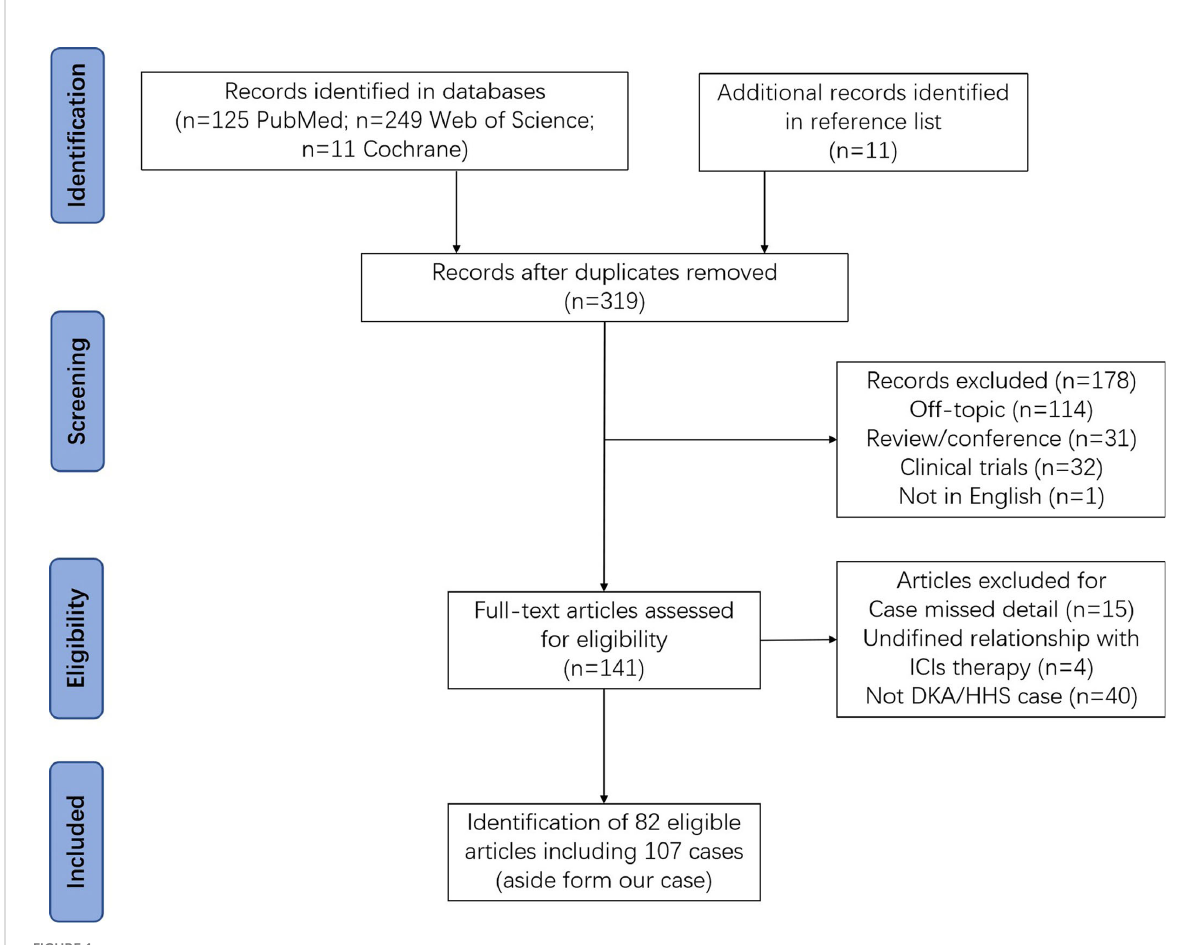
FIGURE 1 Flow diagram for the systematic